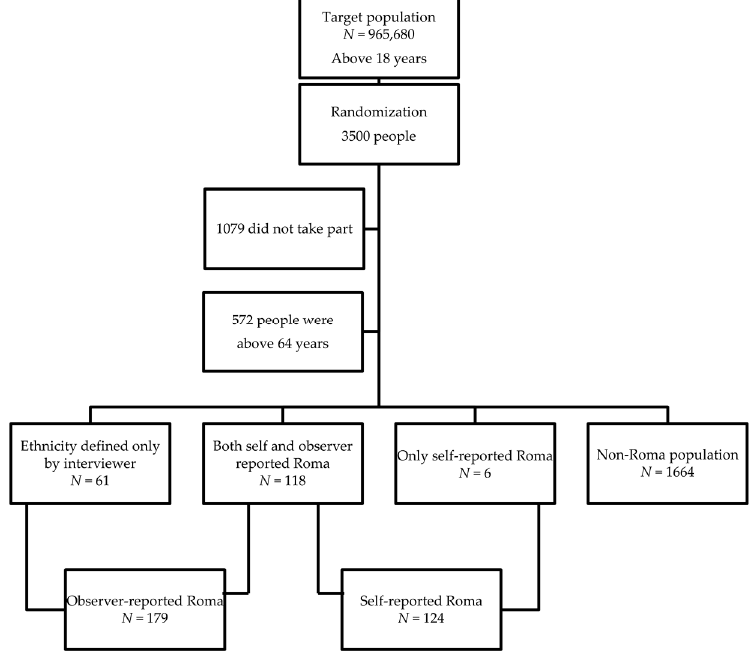
Figure 1. Sampling process of the study.